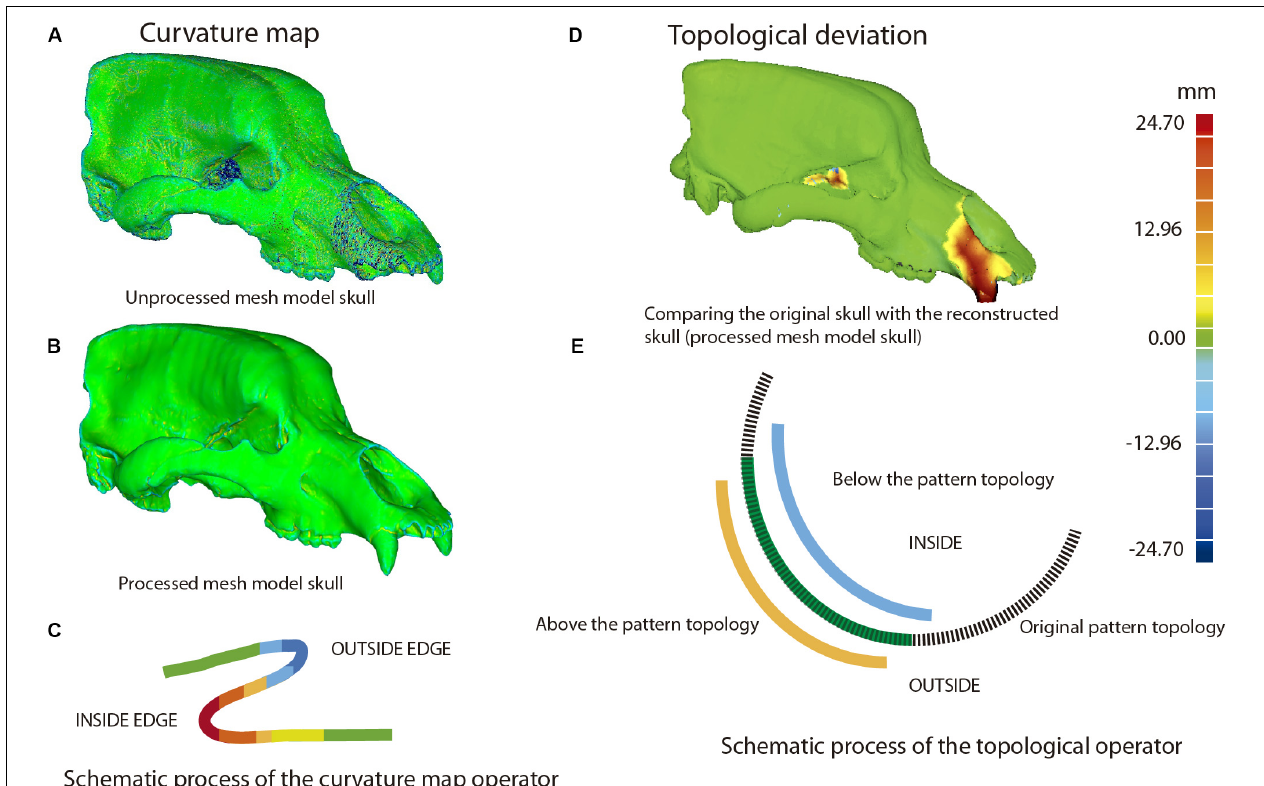
FIGURE 11 | Example of topological deviations using the dataset of Ursus ingressus (PIUW3000/5/105) as an example. (A–C) First postprocessing mesh, based on the curvature map, unprocessed mesh (A) , and processed mesh (B) . (C) Schematic process of the curvature map operator: outside edge, cold colors; inside edge, warm colors. (D) Second postprocessing mesh, consisting of topological deviations. The regions of warm colors correspond with the reconstructed bone parts. (E) Schematic process of the operator of topological